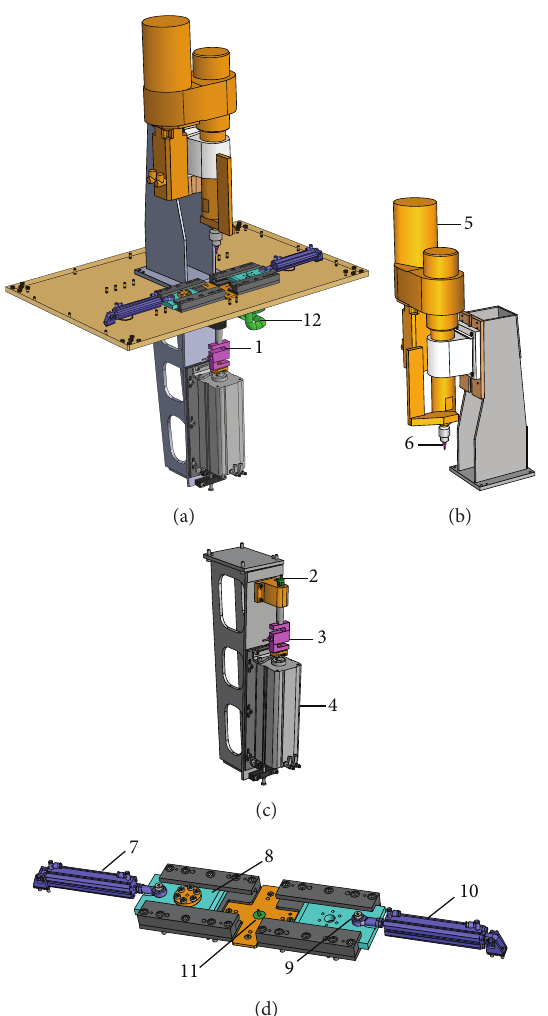
Figure 11: Lap-shear strengths of DC04/GFRP and DC04/CFRP joints with load adjusted formed and predrilled FRP bore